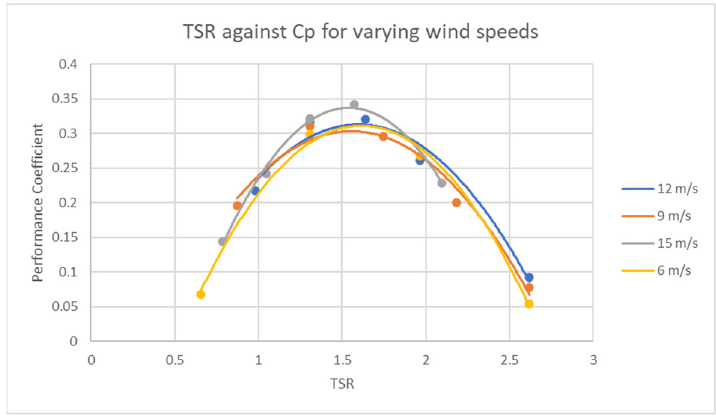
Figure 9. Performance curve for varying wind speeds.